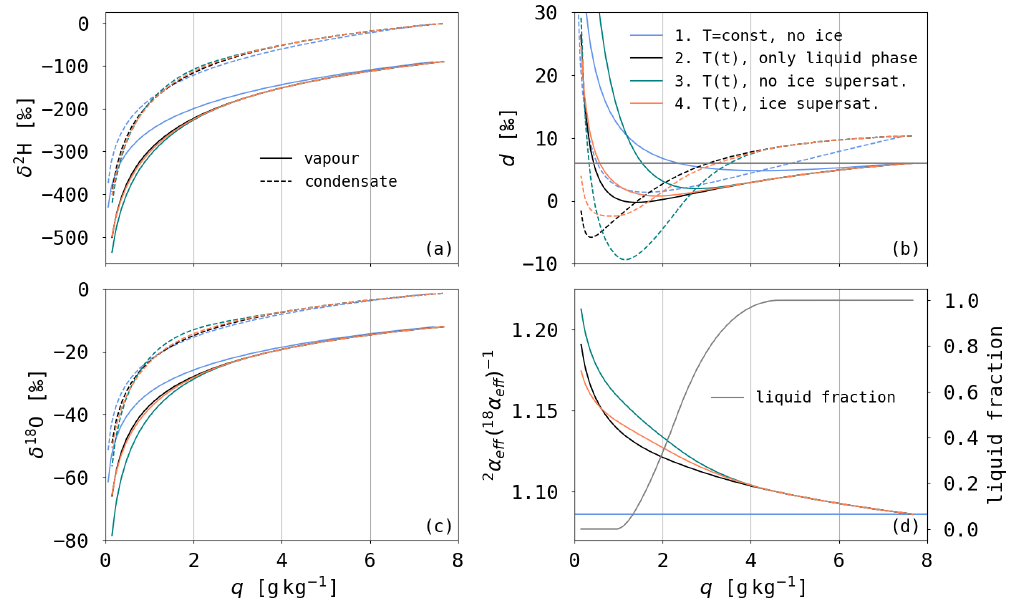
Figure A1. Modelled (a) δ 2 H, (b) d and (c) δ 18 O of water vapour (solid lines) and condensate (dashed lines) versus specific humidity q during Rayleigh fractionation with different model setups (see text for details). Furthermore, the ratio of 2 α eff and 18 α eff for each model setup as a function of q and the liquid fraction for the two setups with ice cloud formation is shown in panel (d)